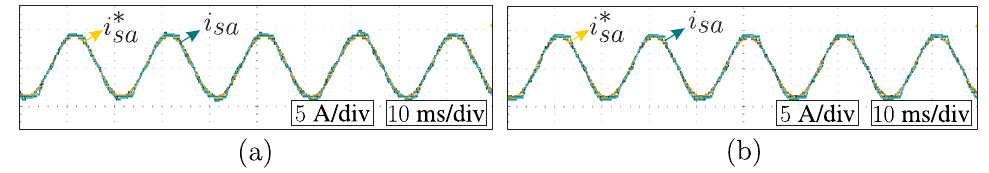
Figure 14. Results of L m parameter variation. ( a ) L m = 230 mH. ( b ) L m = 630